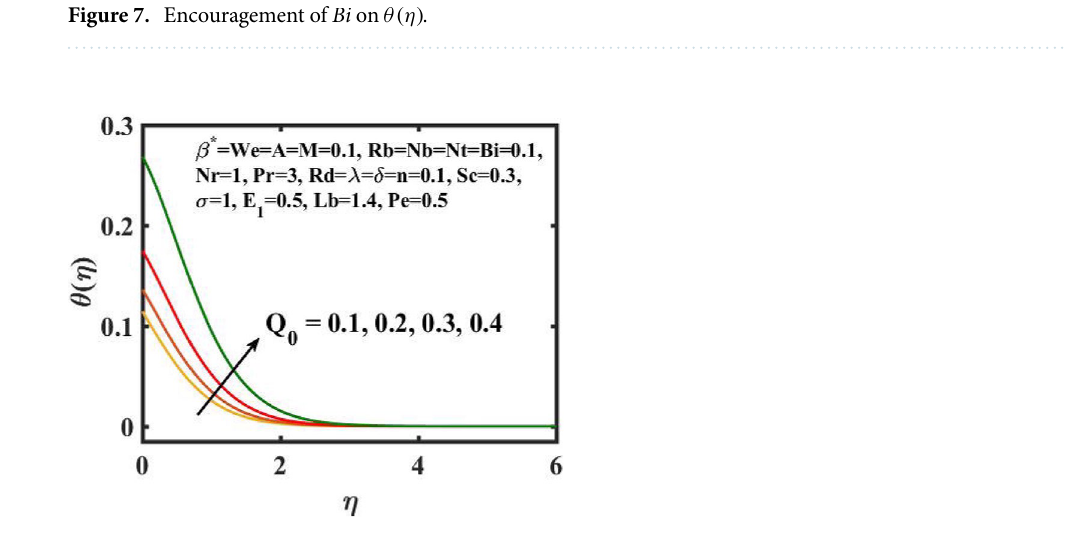
Figure 8. Encouragement of Q 0 on θ(η)